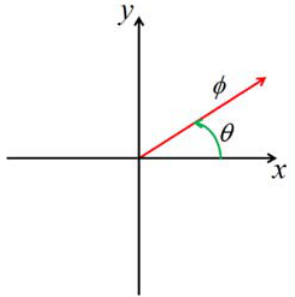
Figure 6. Relation between x-y coordinates and angles of  and θ .